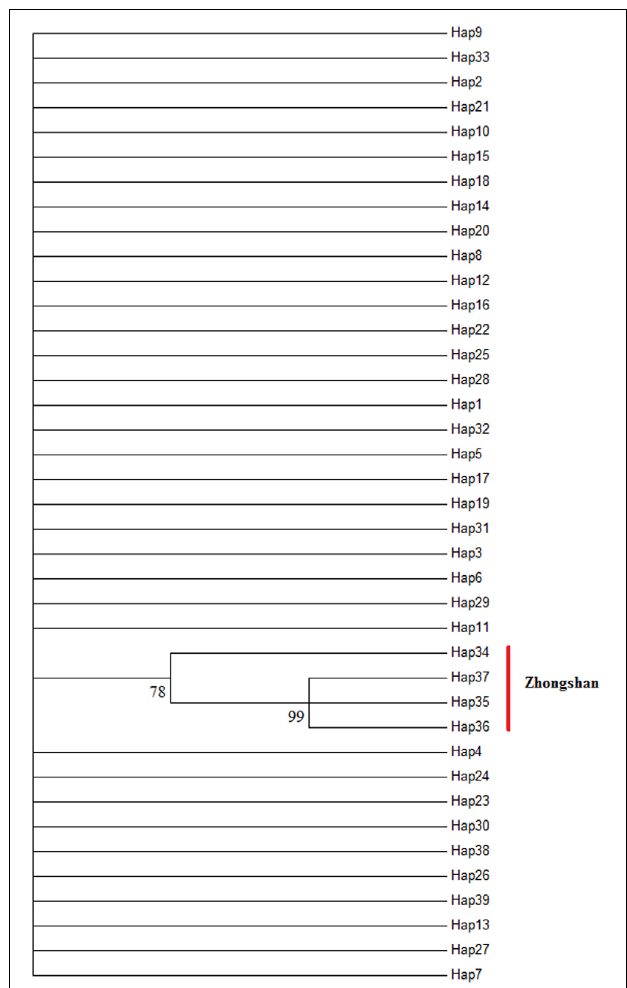
FIGURE 3 | Molecular neighbor-joining phylogenetic tree of Konosirus punctatus developed using Cytb data. The detailed haplotype representation is similar as shown in Figure 5 . Branch support values (higher than 70%) in